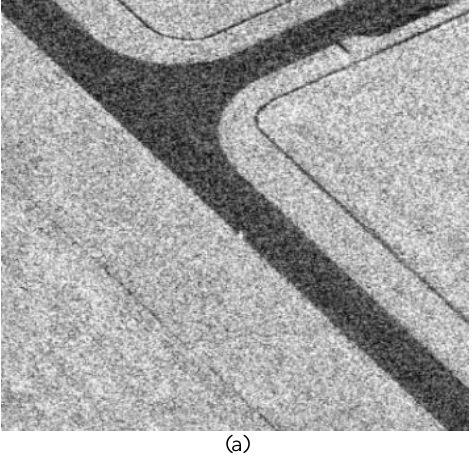
Figure 3. Imaging results of compensated and uncompensated ECS algorithm. (a) Imaging result of ECS with integrated MOCO, (b) Imaging result of ECS without